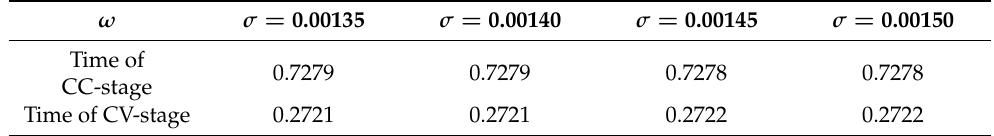
Table 3. Weight of different perturbation